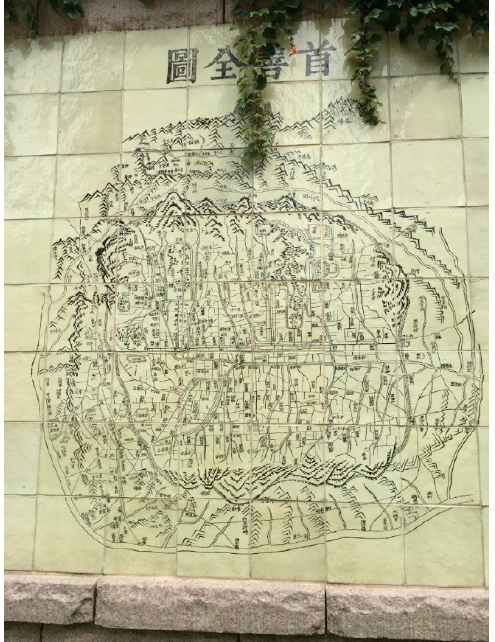
Figure 6. Replica of Doseongdo at the Cheonggyecheon.